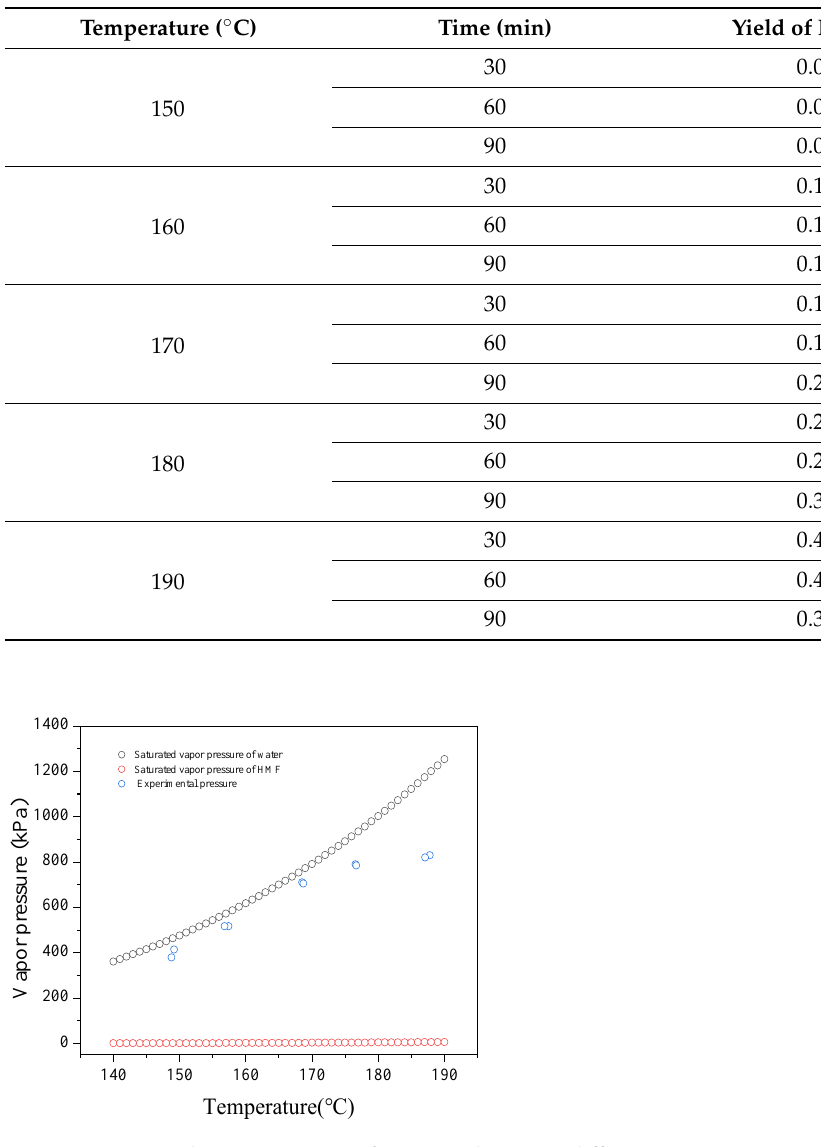
Figure 5. Saturated vapor pressure of water and HMF at different temperatures.